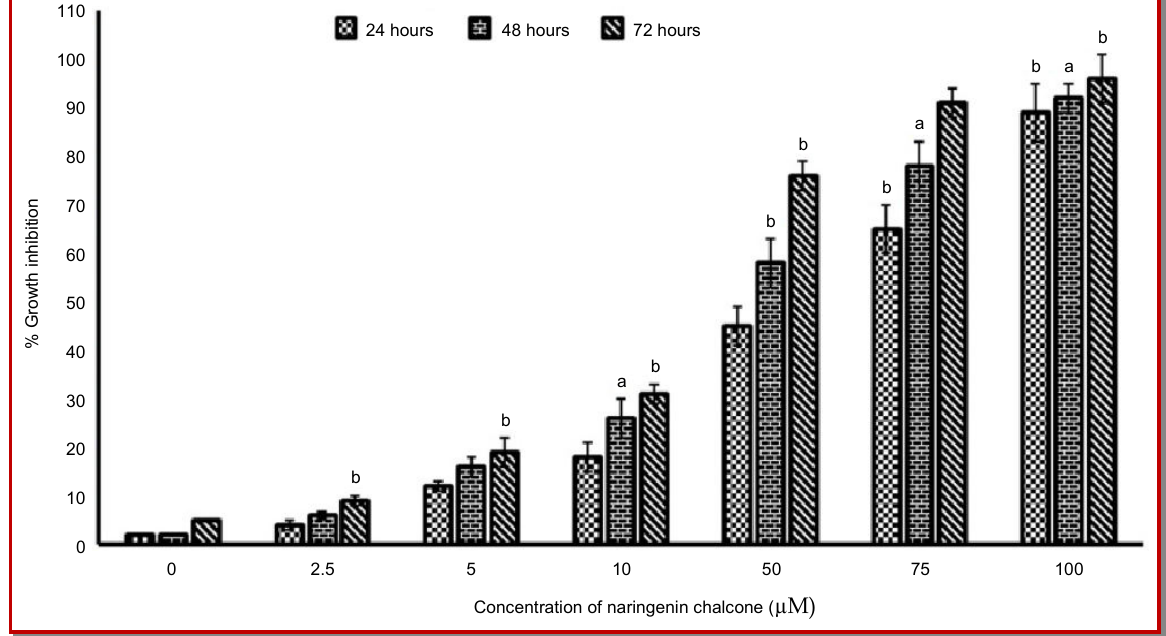
Figure 1: Effect of naringenin chalcone on the cell viability of U87MG human glioblastoma cells. The cells were treated with differ- ent doses of the drug and at three different time intervals. Data are shown as the mean ± SD of three independent